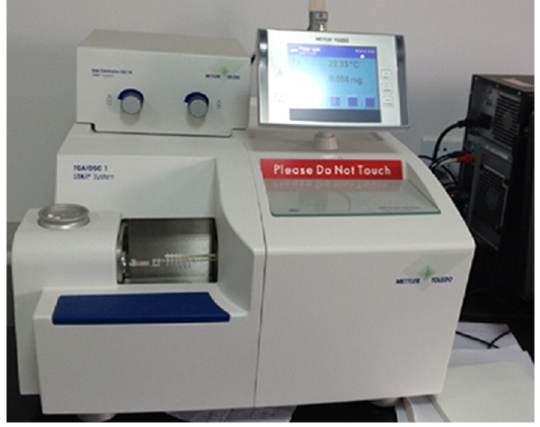
Figure 5. Thermogravimetric